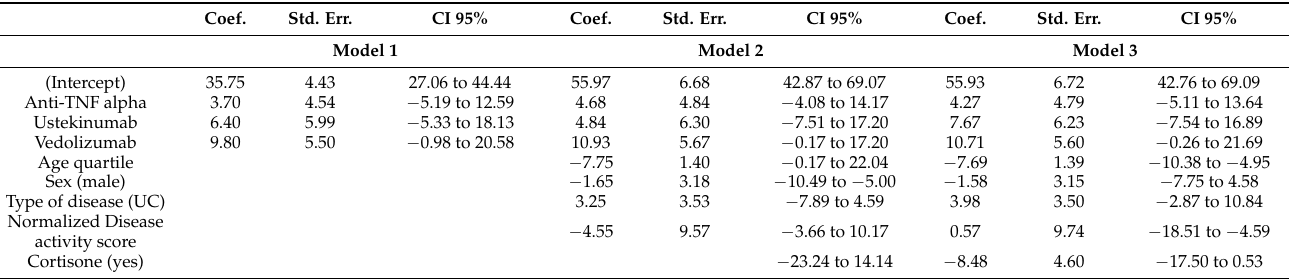
Table 5. Rank-based estimation regression on T1 S1/S2 IgG SARS-CoV-2. Coef.